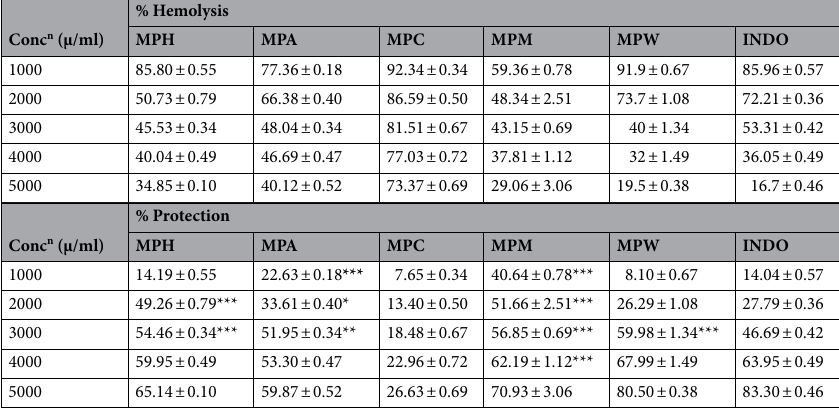
Table 4 presents antimicrobial activity against tested bacterial ( E. coli, S. aureus, P.aeruginosa, B. subtilis) and fungal ( C. albicans, P. chrysogenum , A. niger, A. flavus) strains using agar well diffu-